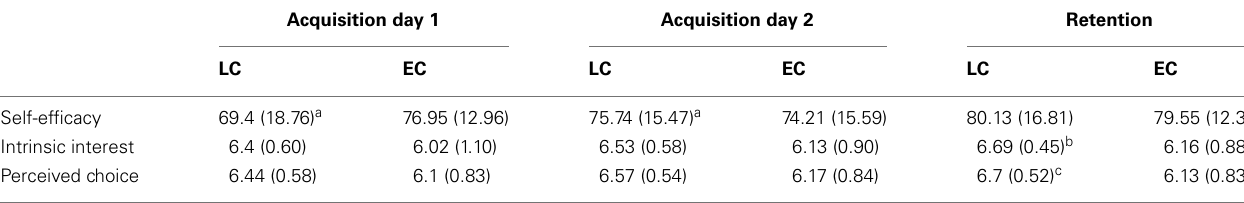
Table 2 | Means (standard deviations) for self-efficacy, intrinsic interest, and perceived choice at each time point by group.